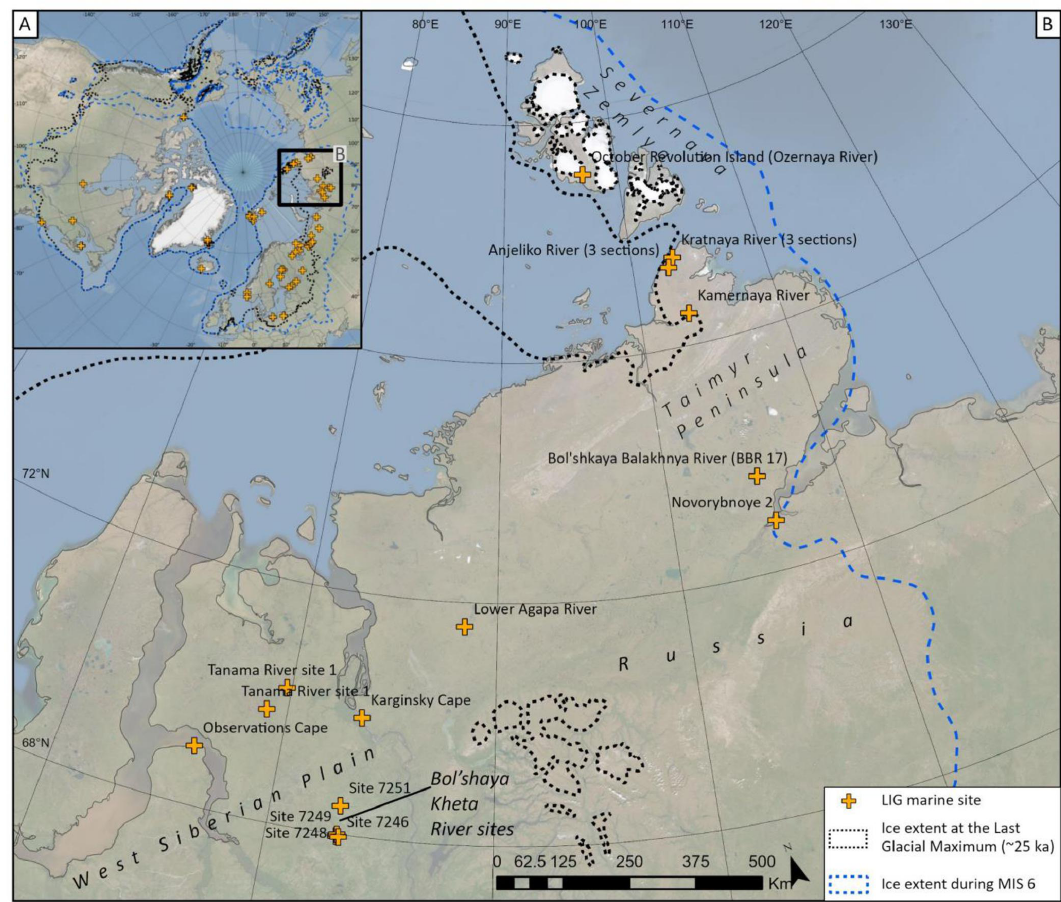
Figure 3. The location of LIG marine sites in the Taimyr Peninsula and West Siberian Plain, Russia. Panel (a) situates the sites in the Northern Hemisphere, whereas panel (b) provides a regional map. Sites plotted on this map are detailed in Sect. 6.1–6.11. Extent of MIS 6 and Last Glacial Maximum ice sheets after Batchelor et al. (2019). Scale calculated at the centre of the mapped area. Base layer: ArcGIS World